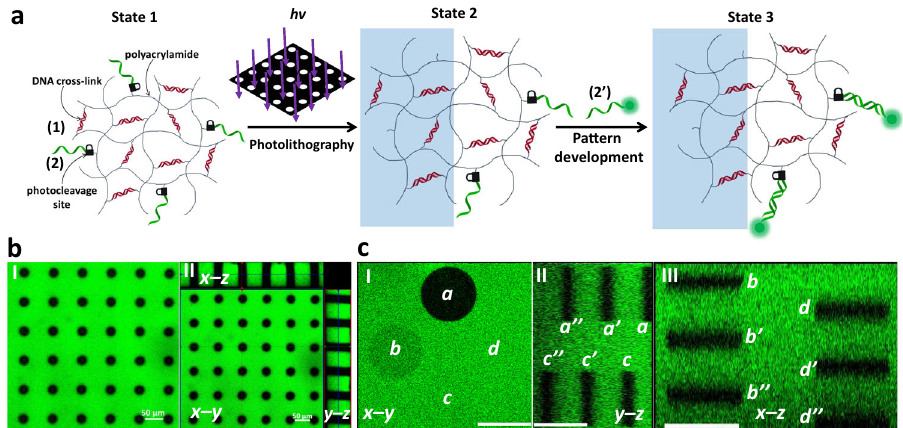
Fig. 2 Light-induced patterning and imaging of a photoresponsive polyacrylamide hydrogel fi lm functionalized with (1) and the o- nitrobenzylphosphate ester nucleic acid (2). a Photolithographic patterning of the hydrogel through a circular-hole containing mask ( λ = 365 nm), and the fl uorescence imaging of the resulting pattern by the hybridization of fl uorescein labeled (2 ’ ) with the tethers (2) associated with the non-irradiated domains. b Panel I — Fluorescence confocal microscope imaging of the patterned hydrogel. Panel II — Three-dimensional confocal microscope imaging of the hydrogel fi lm across the x-y, x-z, and y-z planes. Scale bars are 50 μ m. c Fluorescence confocal microscope imaging of twelve layered and positioned circular domains generated by two-photon laser scanning confocal microscope lithographic patterning process ( λ = 740 nm) using different spatial and positional focusing depths. Panel I — Confocal microscope imaging of the x-y plane consisting of four rectangular circular patterns generated at different focal depths. Panel II — Confocal microscope imaging of the two-photon laser patterned hydrogel fi lm across the y-z plane where the imaging microscope is focused at patterned columns a and c . Panel III — Confocal microscope imaging of the two-photon laser patterned hydrogel fi lm across the x-z plane where the imaging microscope is focused at patterned columns b and d . Scale bars correspond to 20 μ m. Realizing that the patterned fi lms reveal a thickness of ca. 80 μ m, the UV light penetrates across the entire z dimension of the thin fi lm layer, and thus the depth pro fi le of the patterns correspond to the fi lm thickness. This is supported by the depth of the optical images of the patterns that coincide with the macroscopic thickness of the fi lm. N = 4 independent experiments were